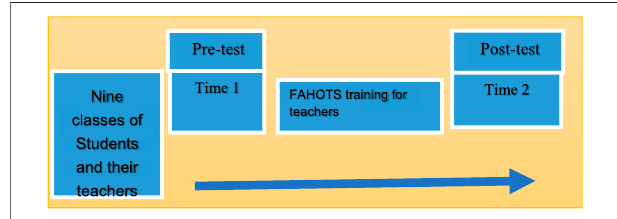
FIGURE 1 | Single-group pre-test-post-test design, Adapted from McMillan and Schumacher